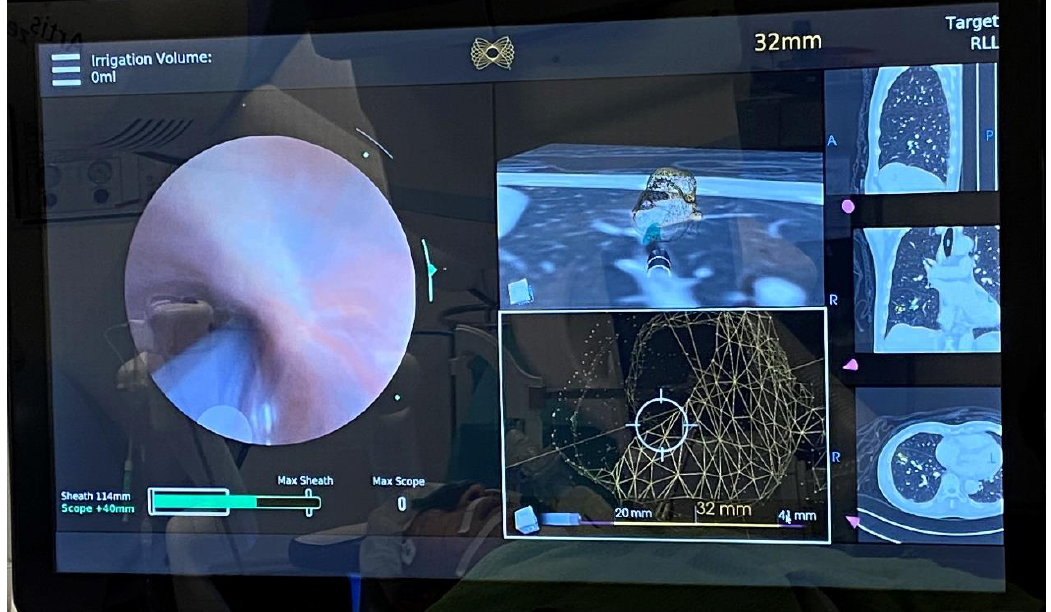
Figure 5. During robotic-assisted bronchoscopy by Auris Monarch TM , multiple panels can be visualized simultaneously: the left-hand panel shows the real-time bronchoscopic view, the middle ones show the bull’s eye view with the centered crosshair and the lesion (in yellow); the right-hand panels show the preoperative CT scan images in three perpendicular axes.